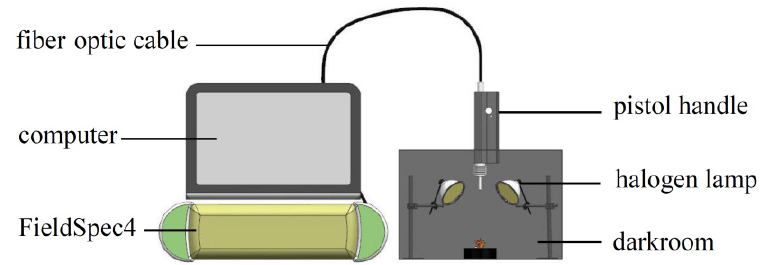
Figure 2. Spectrum acquisition test bench .